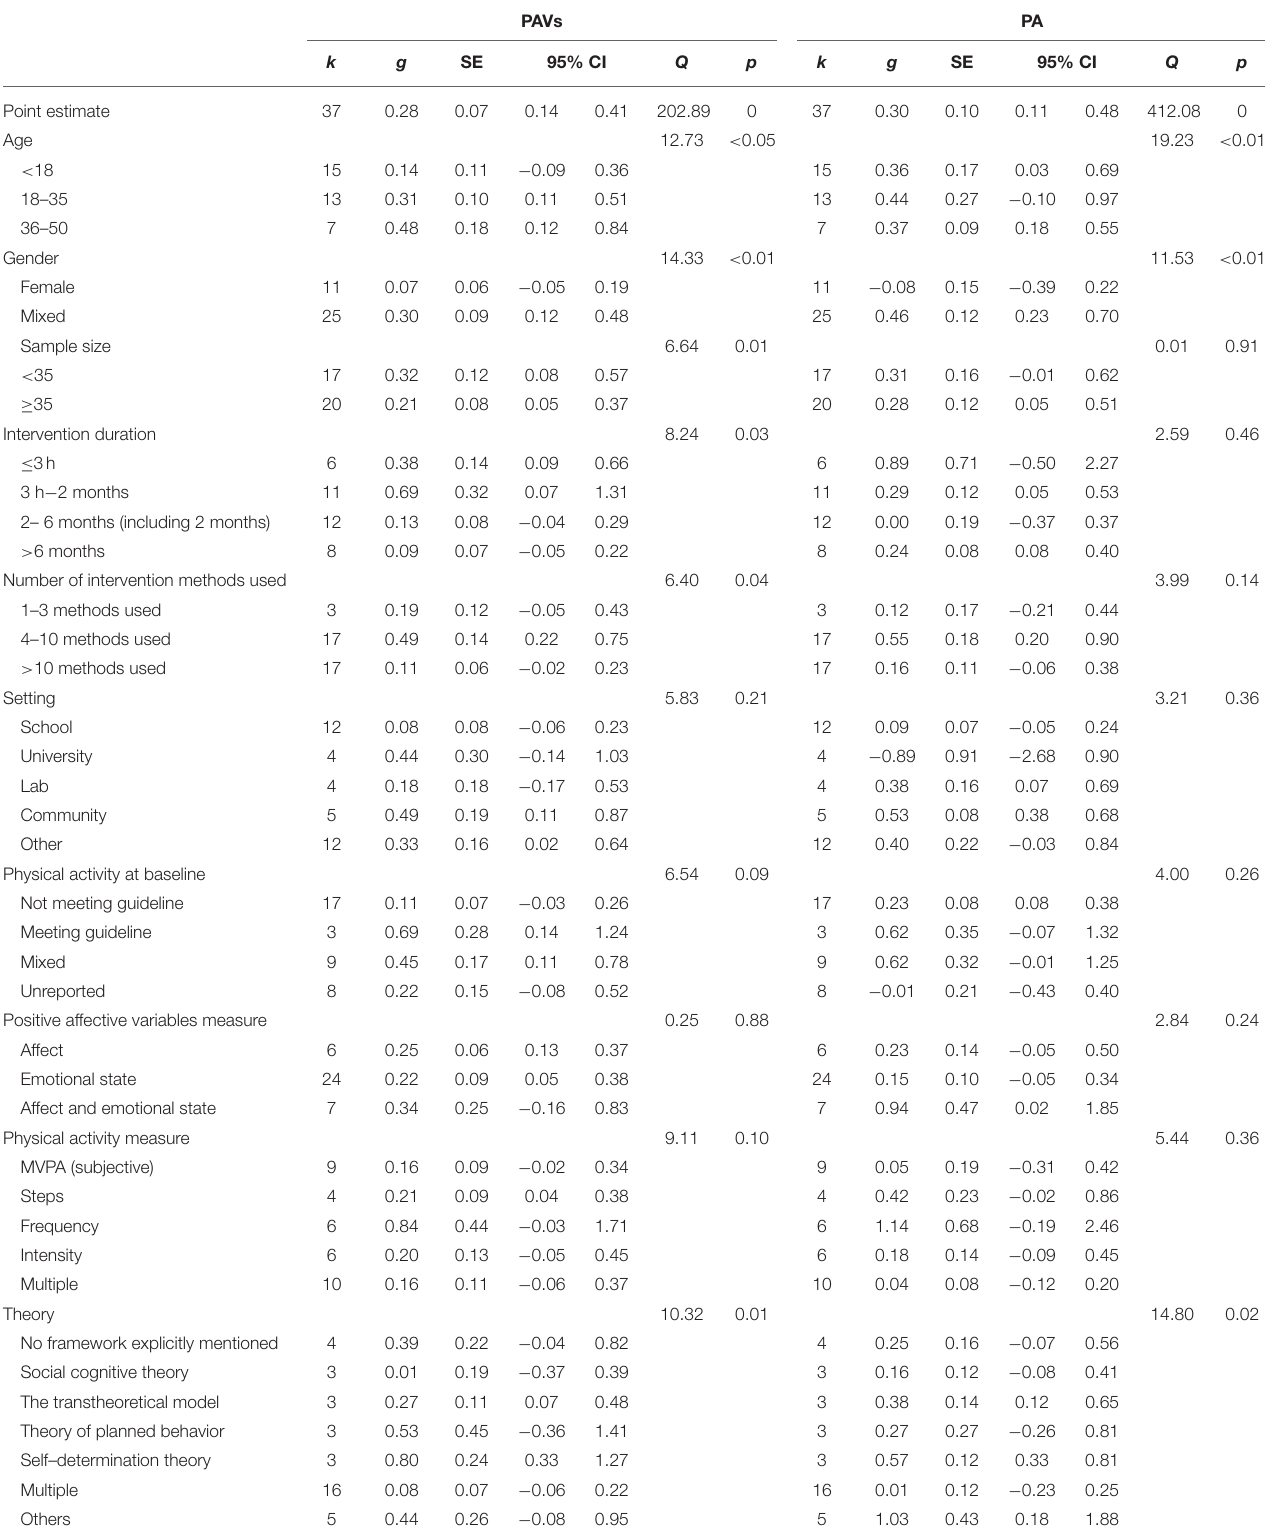
TABLE 3 | Demography and methodology effects of experimental effects on PAVs and